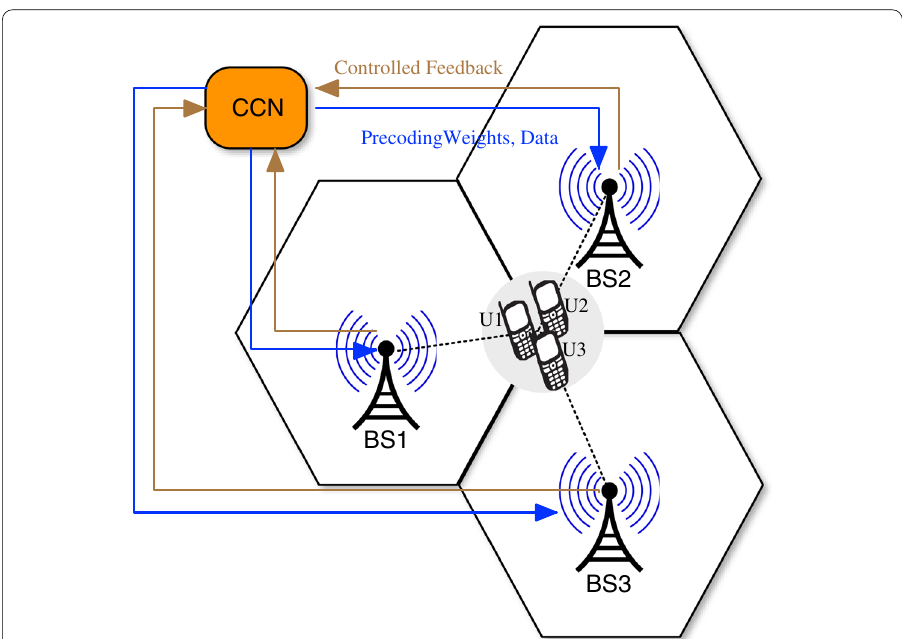
Fig. 1 A simple schematic model for the considered